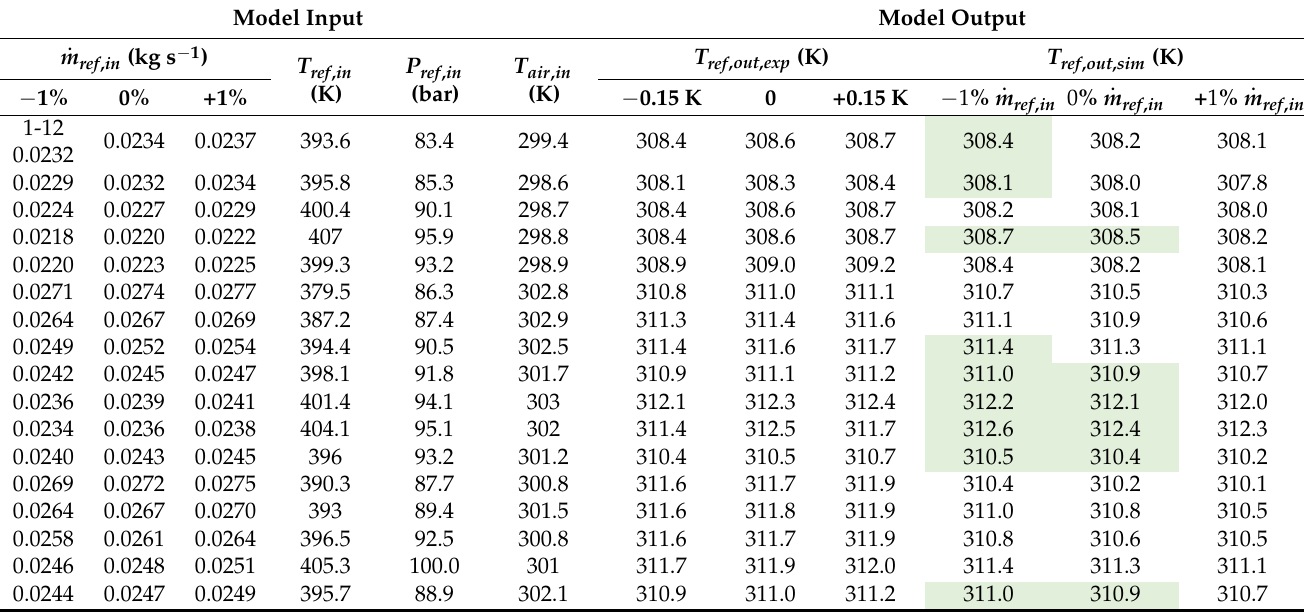
Table 1. Effect of the mass flow rate variation due to the accuracy of the mass flowmeter on the predicted outlet temperature of the refrigerant. The actual measured value is considered for the other inputs. The simulated values within the range of error of the temperature sensor are high- lighted with a green background.